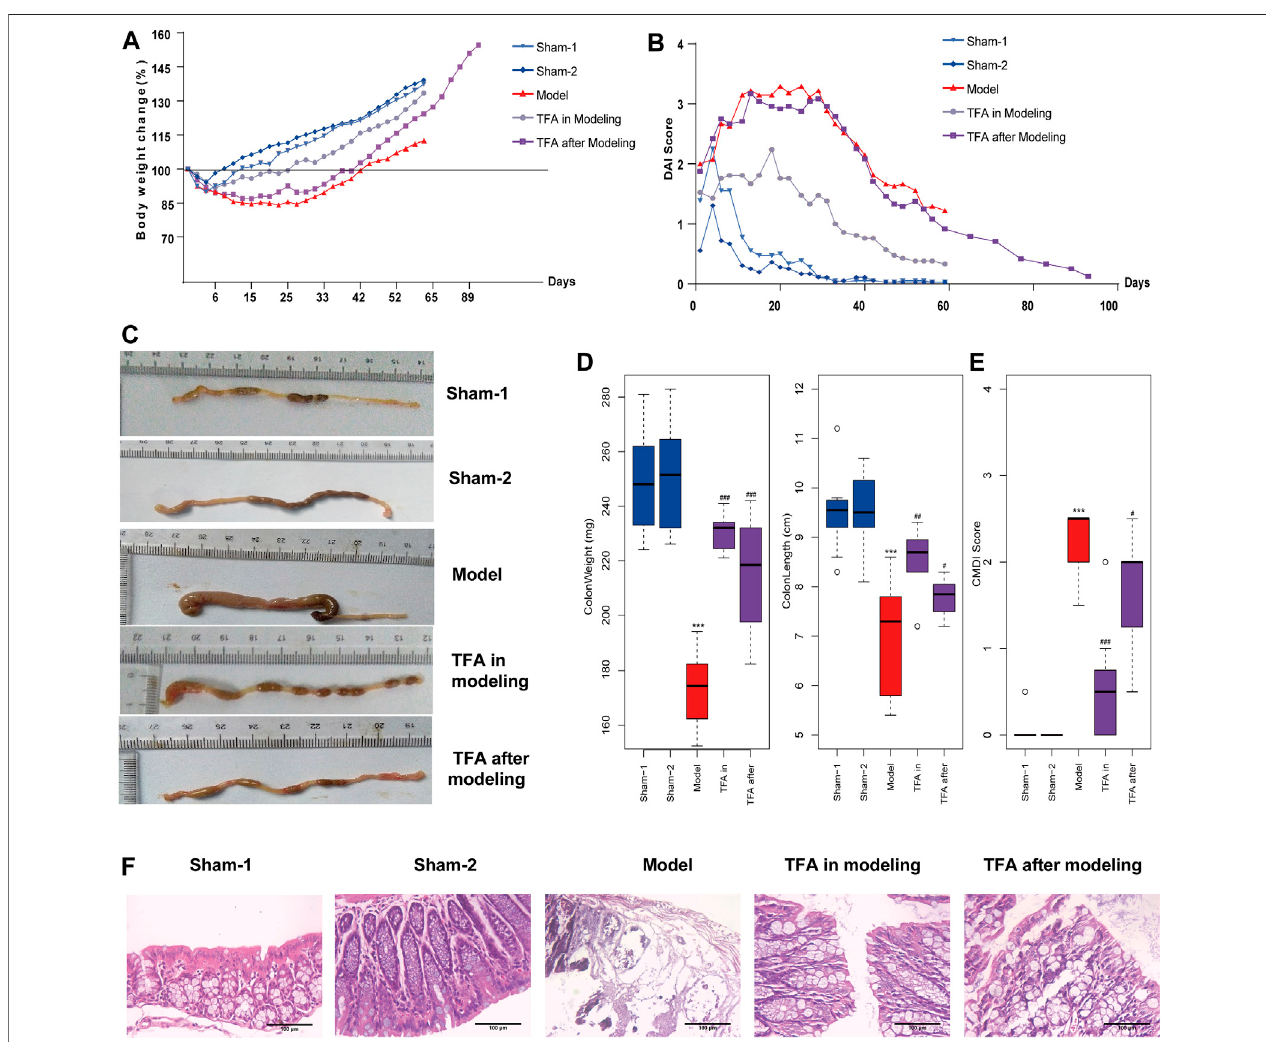
FIGURE 1 | Total fl avone of Abelmoschus manihot L. Medic (TFA) attenuates colitis in the 2,4,6-trinitrobenzene sulfonic acid (TNBS)-induced colitis in mice. (A) Bodyweight change. (B) Disease activity index. (C) After sacri fi cing, colon damage was evaluated by colon length. (D) Length and weight of colon (from the appendix to theanus). (E) Colongrossmorphologicaldamageindex(CMDI)scoreofeach group. (F) Histologicalappearanceofmicecolonicmucosa(HandE,magni fi cation × 100). Dataareshownasthemean ± SEM.*** p < 0.001comparedwithsham-1andsham-2groups, # p < 0.05, ## p < 0.01, ### p < 0.001comparedwiththemodelgroup.